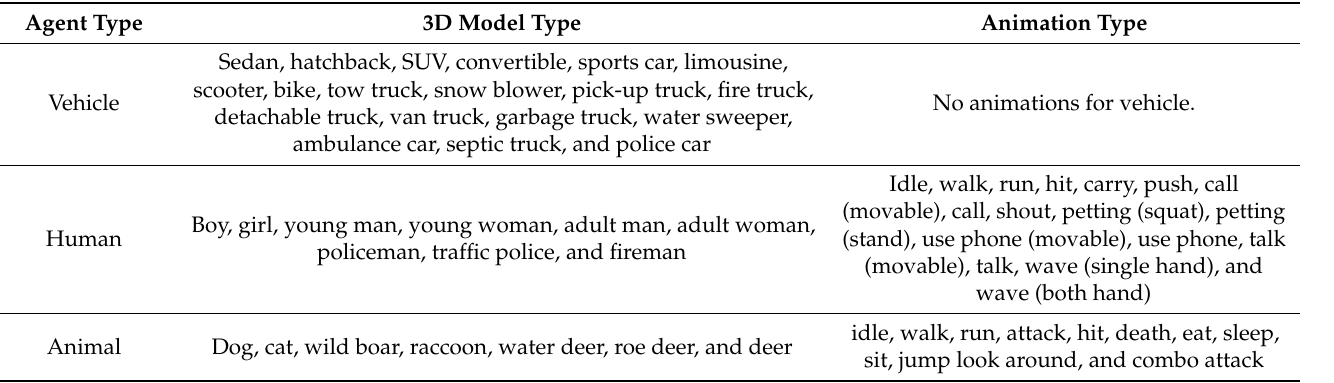
Table 3. 3D model list and animation list of each agent